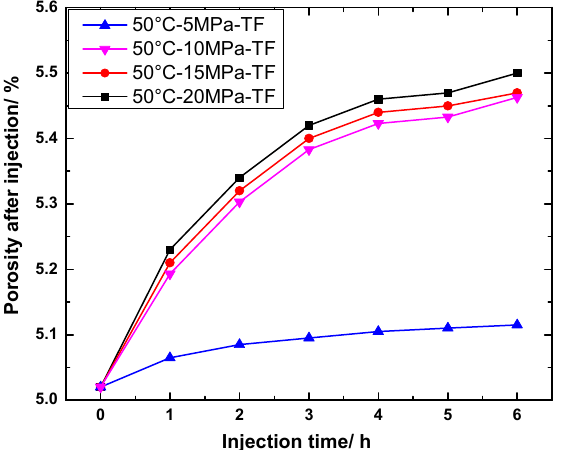
Figure 12. Variation in porosity with time for TF specimens under different pressures.